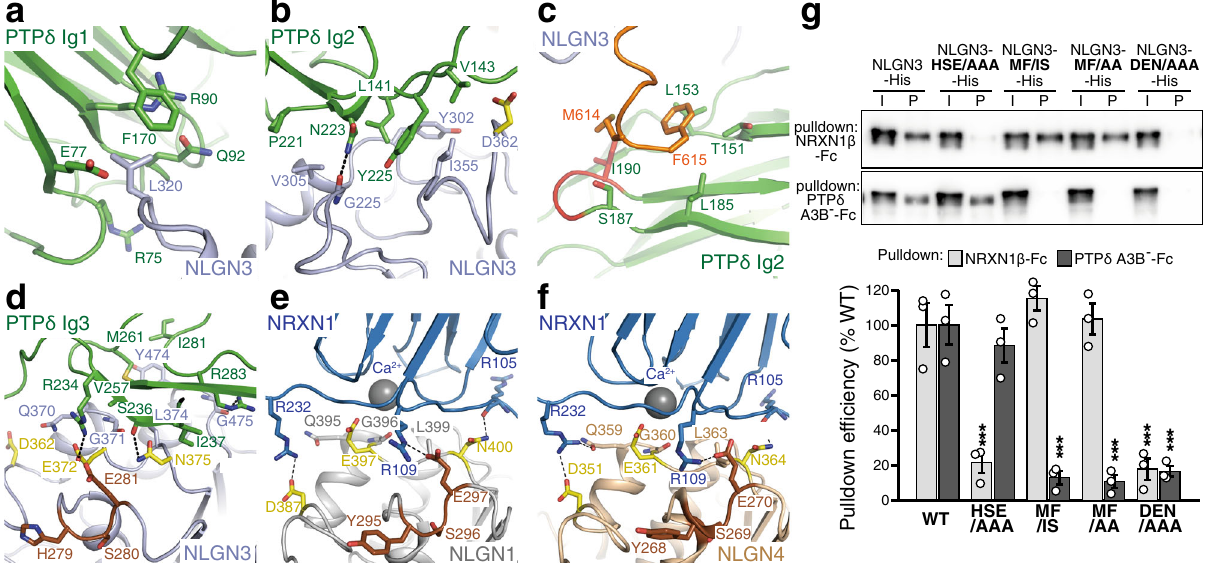
Fig. 4 Binding interfaces between NLGN3 and PTP δ . a – c Close-up views of the NLGN3 α / β -hydrolase-fold core/PTP δ Ig1 interface ( a ), NLGN3 α / β - hydrolase-fold core/PTP δ Ig2 interface ( b ), and NLGN3 ECD C-terminal/PTP δ Ig2 interface ( c ). The coloring scheme is the same as that in Fig. 3b. d – f Close-up views of the NLGN3/PTP δ Ig3 interface ( d ), NLGN1/NRXN1 β (PDB 3B3Q) interface ( e ), and NLGN4/NRXN1 β (PDB 2WQZ) interface ( f ). The coloring scheme is the same as that in ( a ), except that (putative) NRXN/PTP δ -interacting residues (Asp362, Glu372, and Asn375) and NRXN-interacting loop (His279, Ser280, and Glu281) of NLGN3 are yellow and brown, respectively. The bound calcium ion is shown as a gray sphere. The NRXN-interacting residues of NLGN1 (Asp387, Glu397, and Asn400) and NLGN4 (Asp351, Glu361, and Asn364) are yellow. Tyr295, Ser296, and Glu297 of NLGN1, and Tyr268, Ser269, and Glu270 of NLGN4, which correspond to the NRXN-interacting loop of NLGN3, are brown. g NRXN1 β or PTP δ A3B – bound wild-type NLGN3, NLGN3-HSE/AAA, NLGN3-MF/IS, NLGN3-MF/AA, and NLGN3-DEN/AAA mutants with His 6 tag were resolved by SDS-PAGE and blotted with anti-His antibody (top). The pulldown ef fi ciency of wild-type or mutated NLGN3 was quanti fi ed (bottom; n = 3 experiments). Data are mean ± s.e.m. *** p < 0.001, Tukey ’ s test. See Supplementary Table 4 for exact p